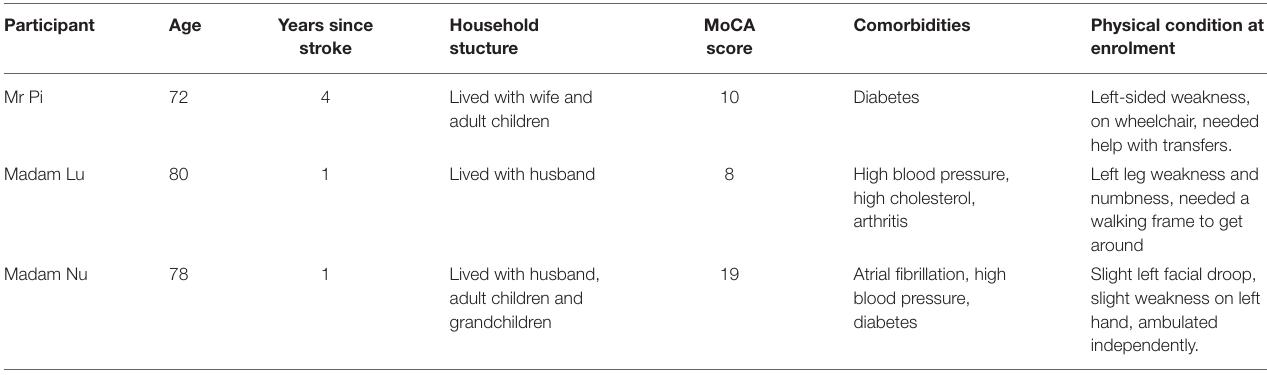
TABLE 1 | Characteristics of participants in case studies. Participant Age Years since Mr Pi 72 4 Lived with wife and